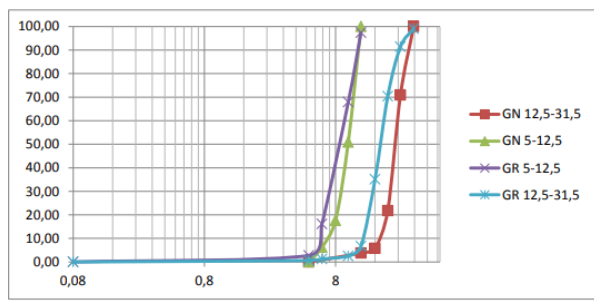
Figure 2. Granometric curve for natural and recycled aggregates used in experimental study (GN: Naturel gravel / GR: recycled gravel).